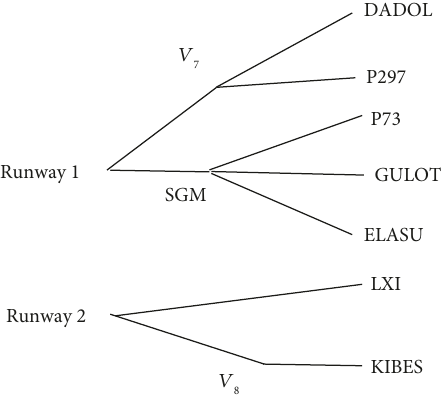
Figure 5: Departure route